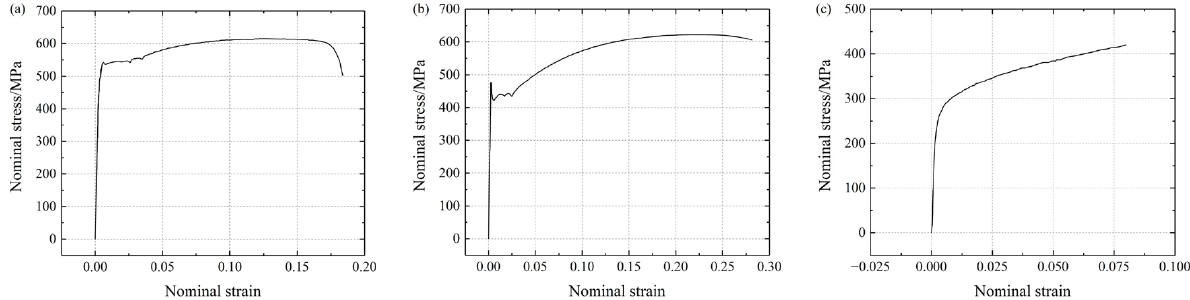
Figure 5. Nominal stress-nominal strain curve: ( a ) Q450NQR1 [25]; ( b ) 16MnDR [26]; ( c ) S30408 [27].